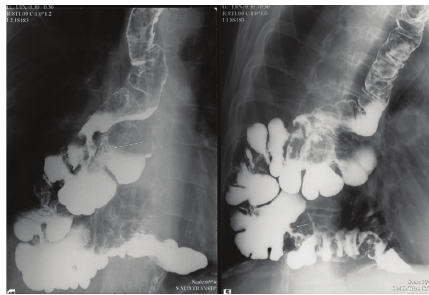
Figure 2: Barium swallow revealed a circumferential mass arising from the colon.